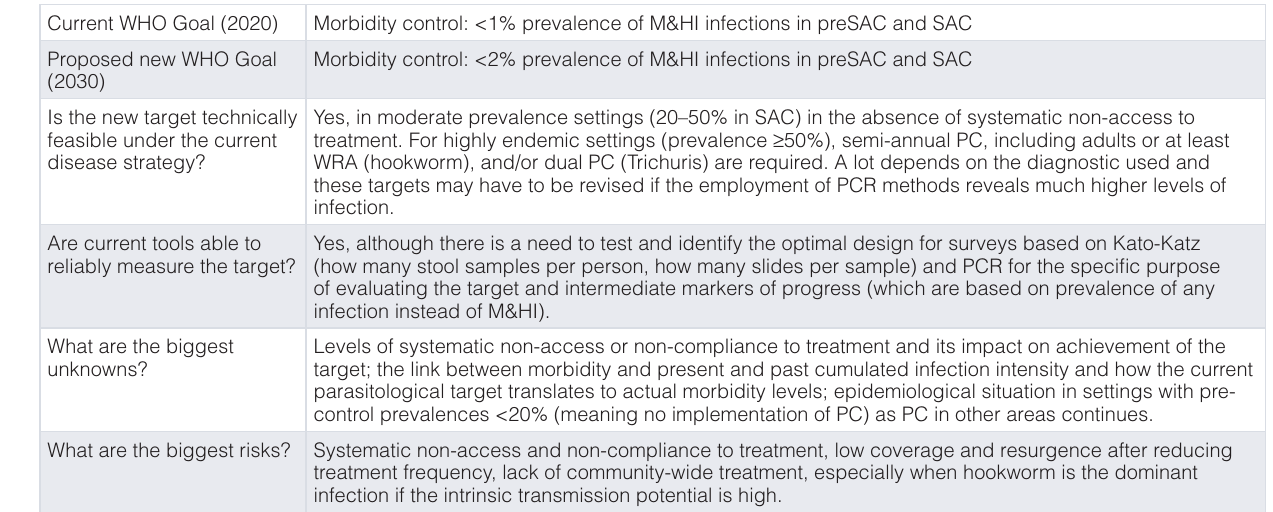
Table 1. Summary of modelling insights and challenges for reaching the WHO 2030 goal for soil-transmitted